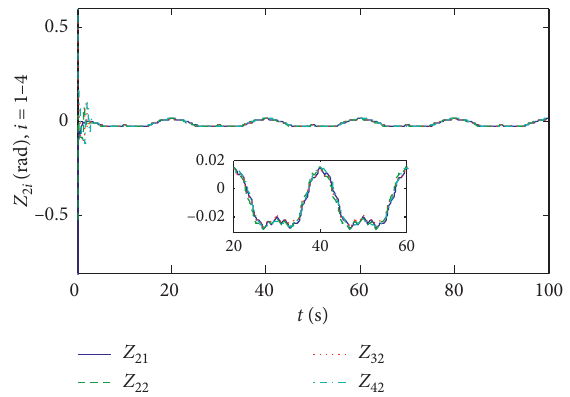
Figure 6: The auxiliary variables Z